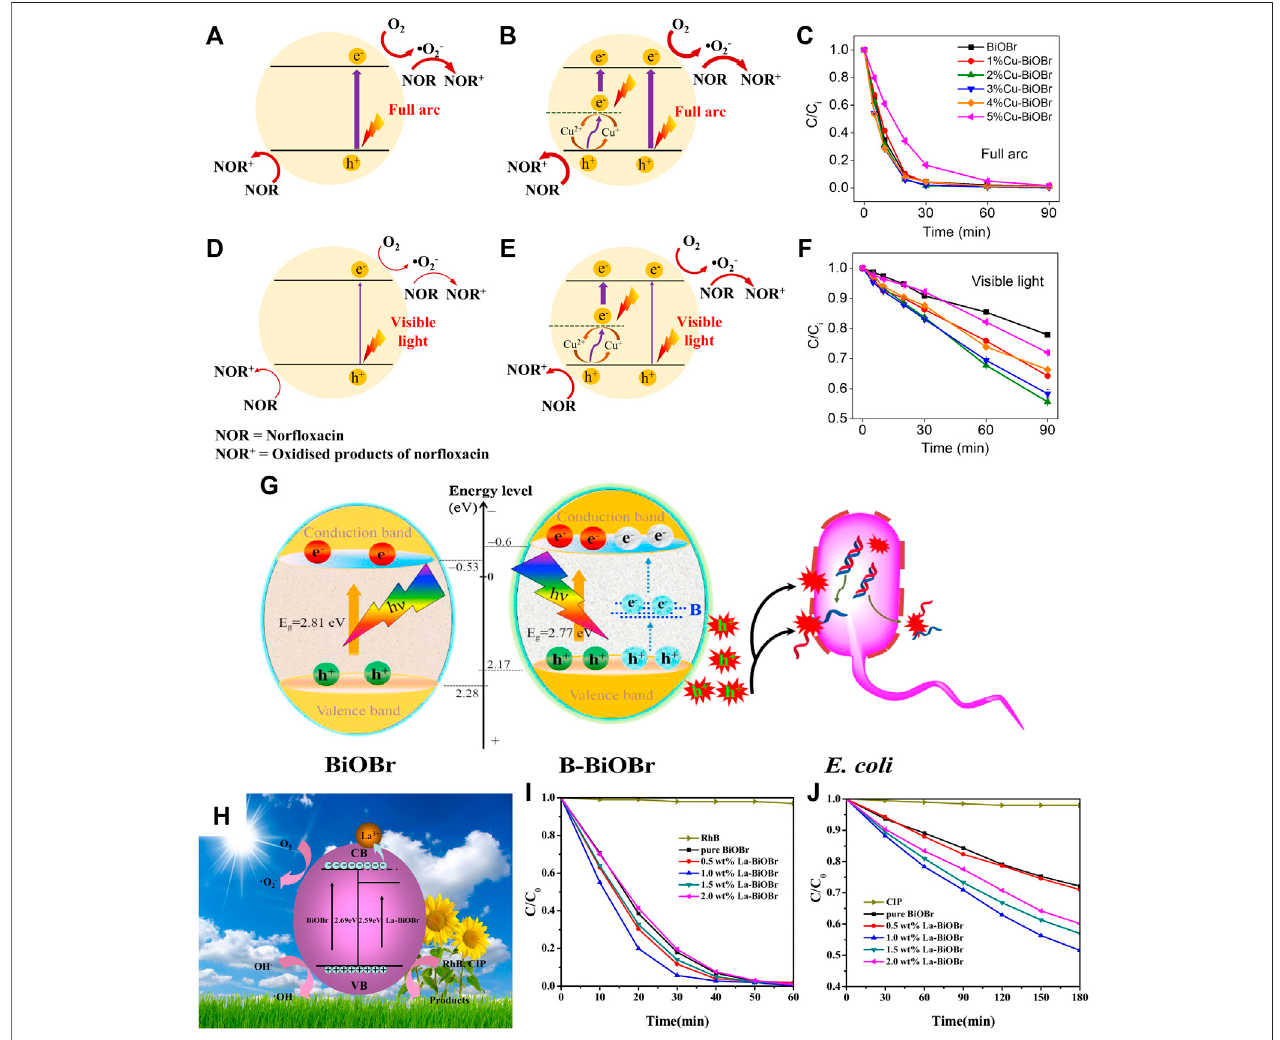
FIGURE7| MechanisticsofphotochargetransportandsurfacetransferonBiOBr (A,D) andCu-BiOBr (B,E) withnor fl oxacinanddissolvedoxygenunderfull (A,B) arcandvisiblelight (D,E) irradiation.Thecorrespondingdegradationkineticsunderfullarc (C) andvisiblelight (F) (Lvetal.,2020). (G) Photocatalyticbacterialinactivation enhancement of B-BiOBr nanosheets (Wu et al., 2016). (H – J) Organic degradation over La 3+ -doped BiOBr and corresponded degradation kinetic for RhB and CIP (Yin et al., 2017).